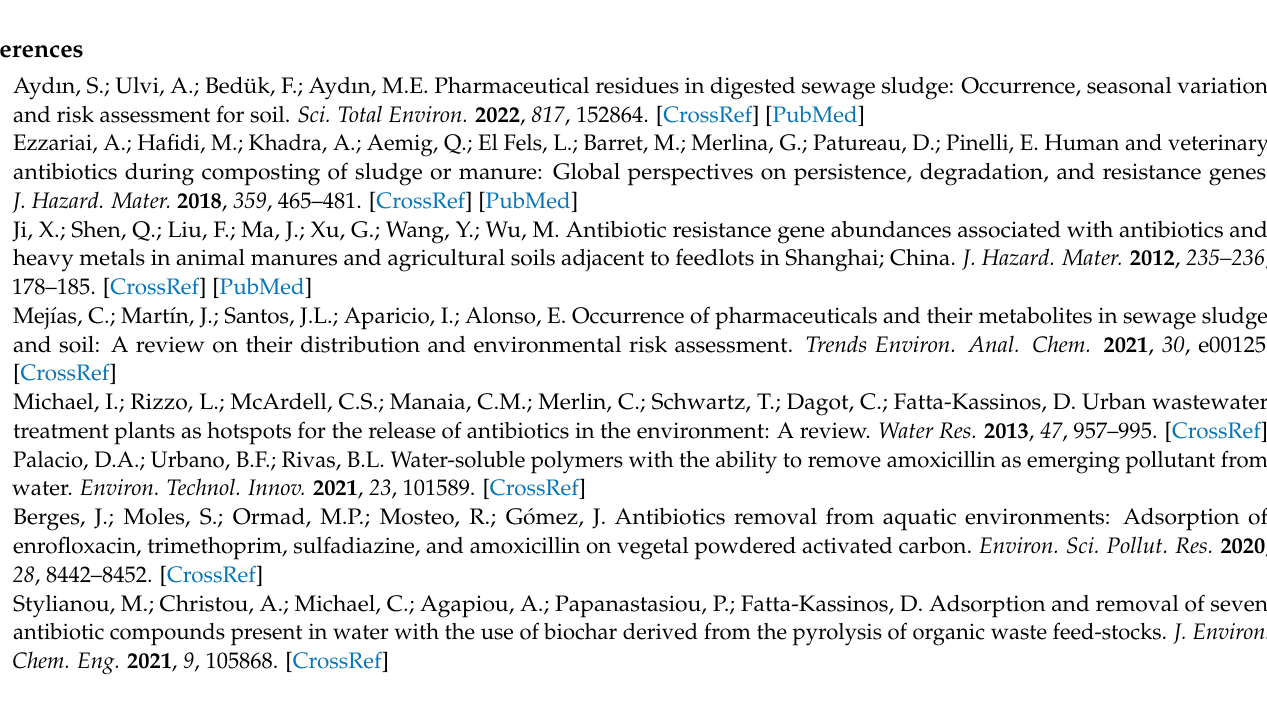
adsorption percentages; Figure S1: Desorption curves for Ciprofloxacin (CIP) in the 17 soils studied. q a : CIP adsorbed onto the soil after a desorption cycle; C eq : CIP concentration in the equilibrium solution; Figure S2: Desorption curves for trimethoprim (TRI) in the 17 soils studied. q a : TRI adsorbed onto the soil after a desorption cycle; C eq : CIP concentration in the equilibrium